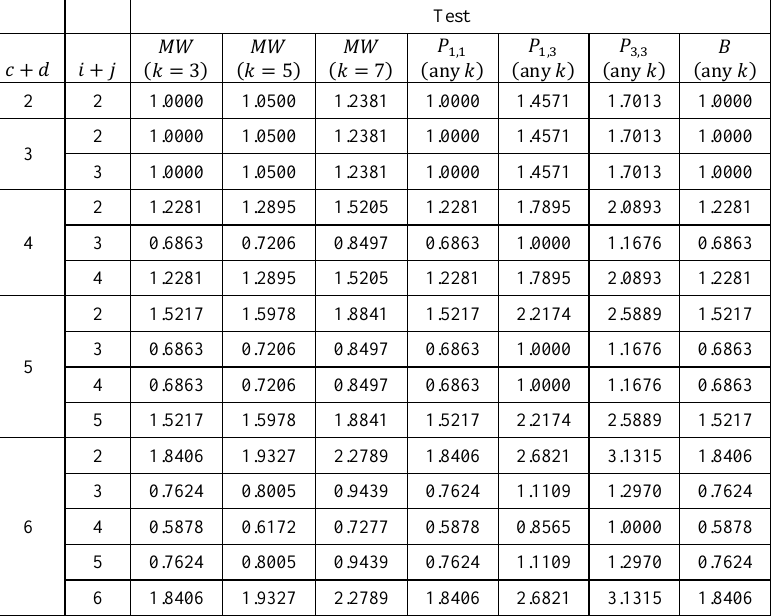
Table 2. AREs of 𝑇 for Uniform distribution w.r.t. different tests 𝑐,𝑑;𝑖,𝑗